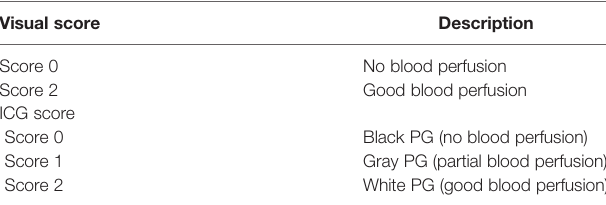
TABLE 1 | Intraoperative parathyroid gland (PG) scoring.